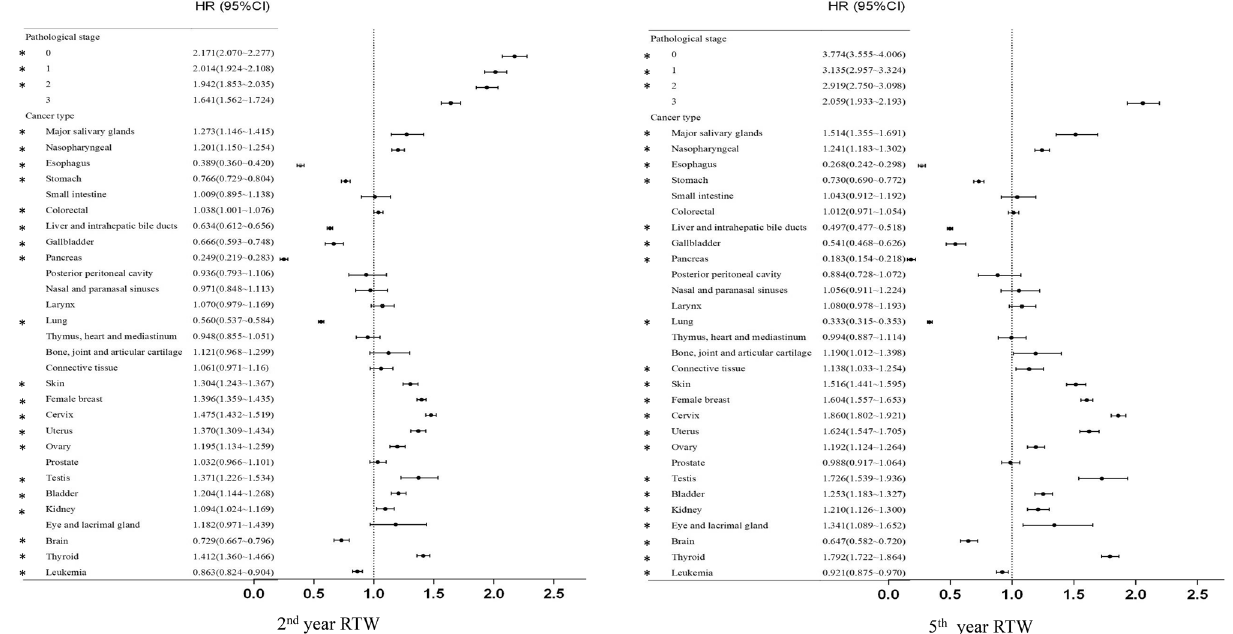
Figure 2. Univariate association between different cancer types and RTW in the 2nd and 5th